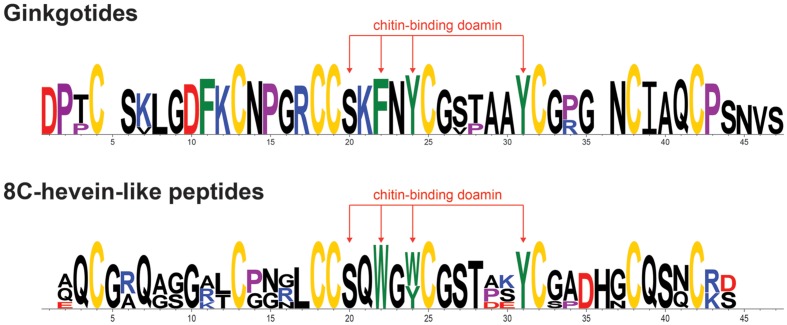
Sequence analysis of the aligned ginkgotides, hevein and 8C-hevein-like peptides. The overall height of the stack indicates the sequence conservation, whereas the height of symbols within the stack indicates the relative frequency of each amino at that position. The cysteine, proline, negatively charged (D and E), positively charged (H, K, and R) and aromatic amino acid residues (F, W, and Y) were yellow, violet, red, blue, and green, respectively.